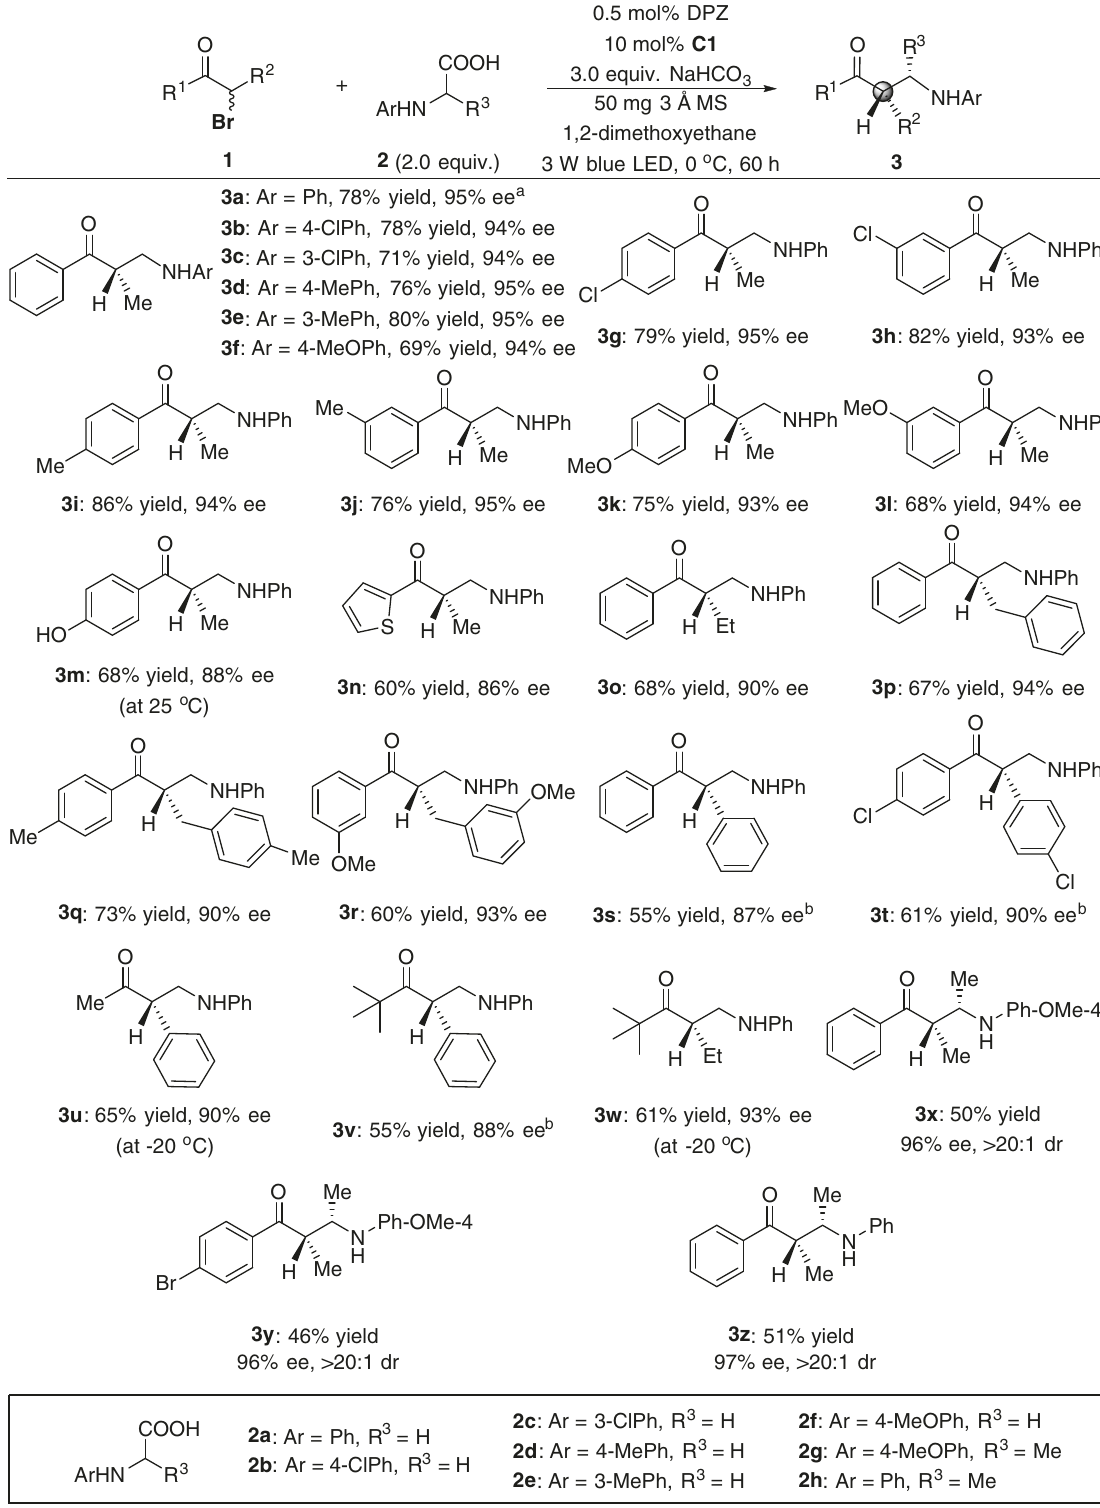
Fig. 2 Substrate scope of N -aryl amino acids and secondary α -bromoketones. Reactions were performed with 1 (0.1 mmol), 2 (0.2 mmol), DPZ (0.5 × 10 − 3 mmol), C1 (0.01 mmol), NaHCO 3 (0.3 mmol), and 3 Å MS (50 mg) in 1,2-dimethoxyethane (1.5 mL) at 0 °C. Yields were determined from the